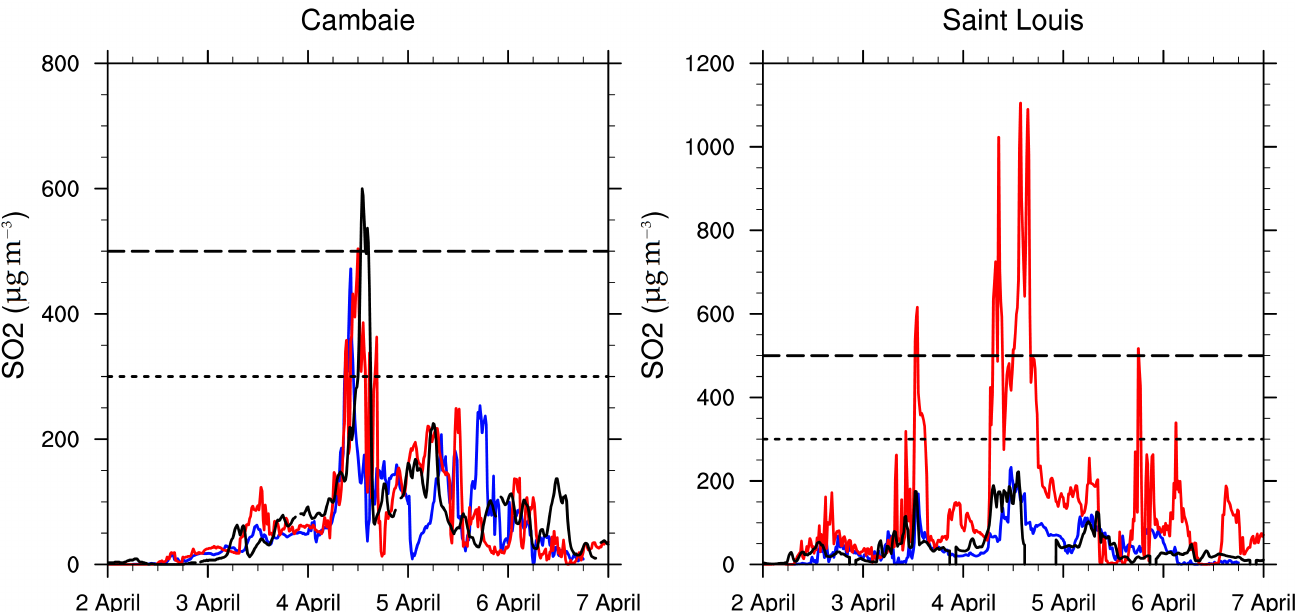
Figure 12. Simulated ground SO 2 concentration (ppb) and surface wind field, 4 April 00:00UTC.